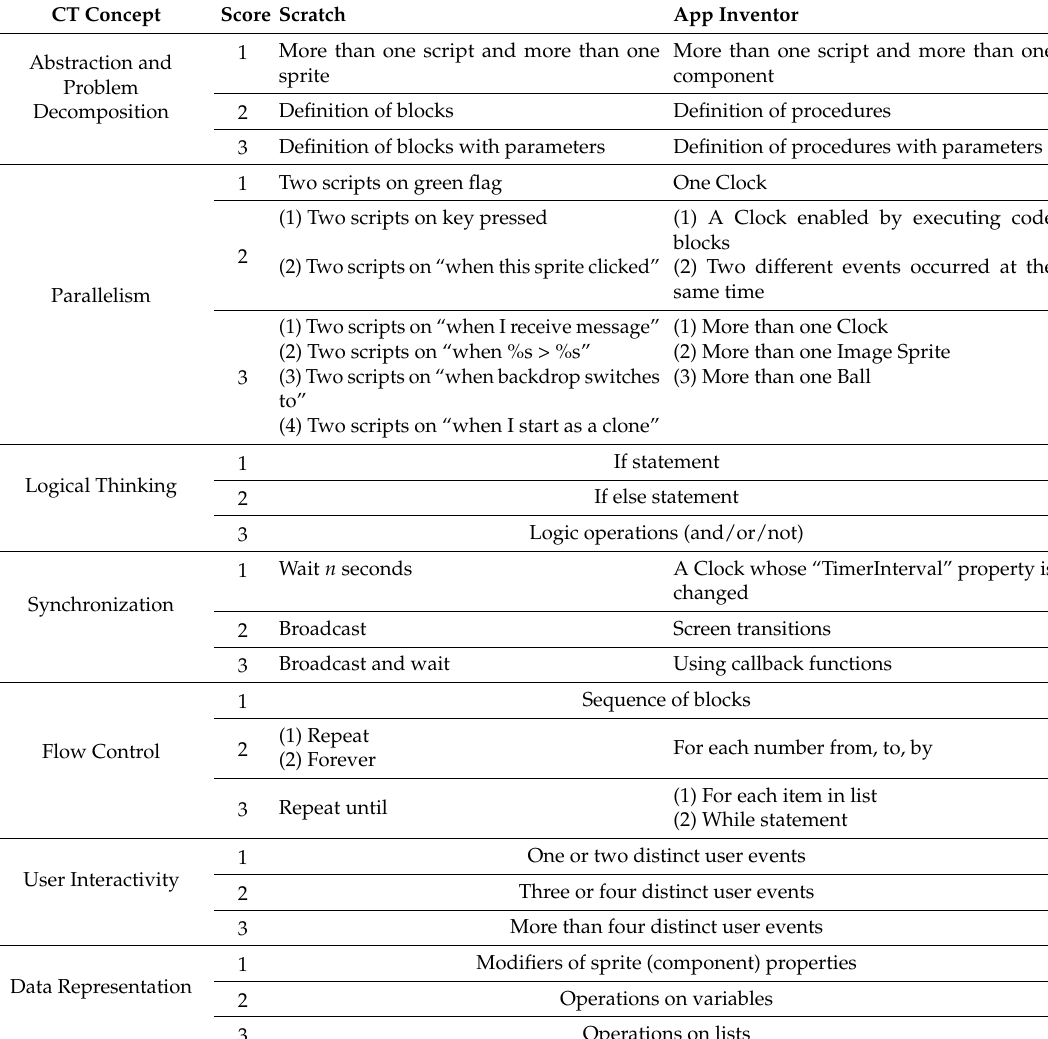
Table 1. The proposed rubric based on the computational thinking (CT) concepts for Scratch and App Inventor. If a project has at least one element in a particular cell, that project will receive the corresponding